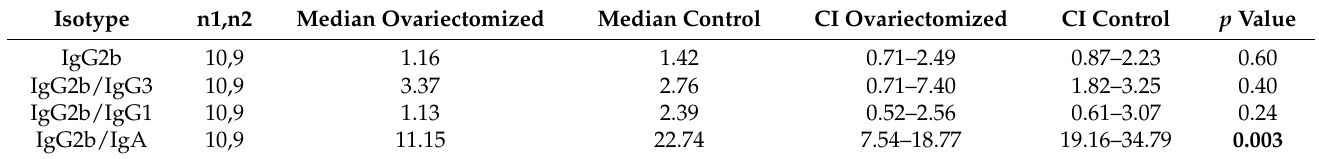
IgG2b results from Figure 2, including animal numbers (n1 for ovariectomized, n2 for control), medians, and CI values, are tabulated. p values are bolded when p < 0.05 for the comparison between groups (Mann–Whitney test).